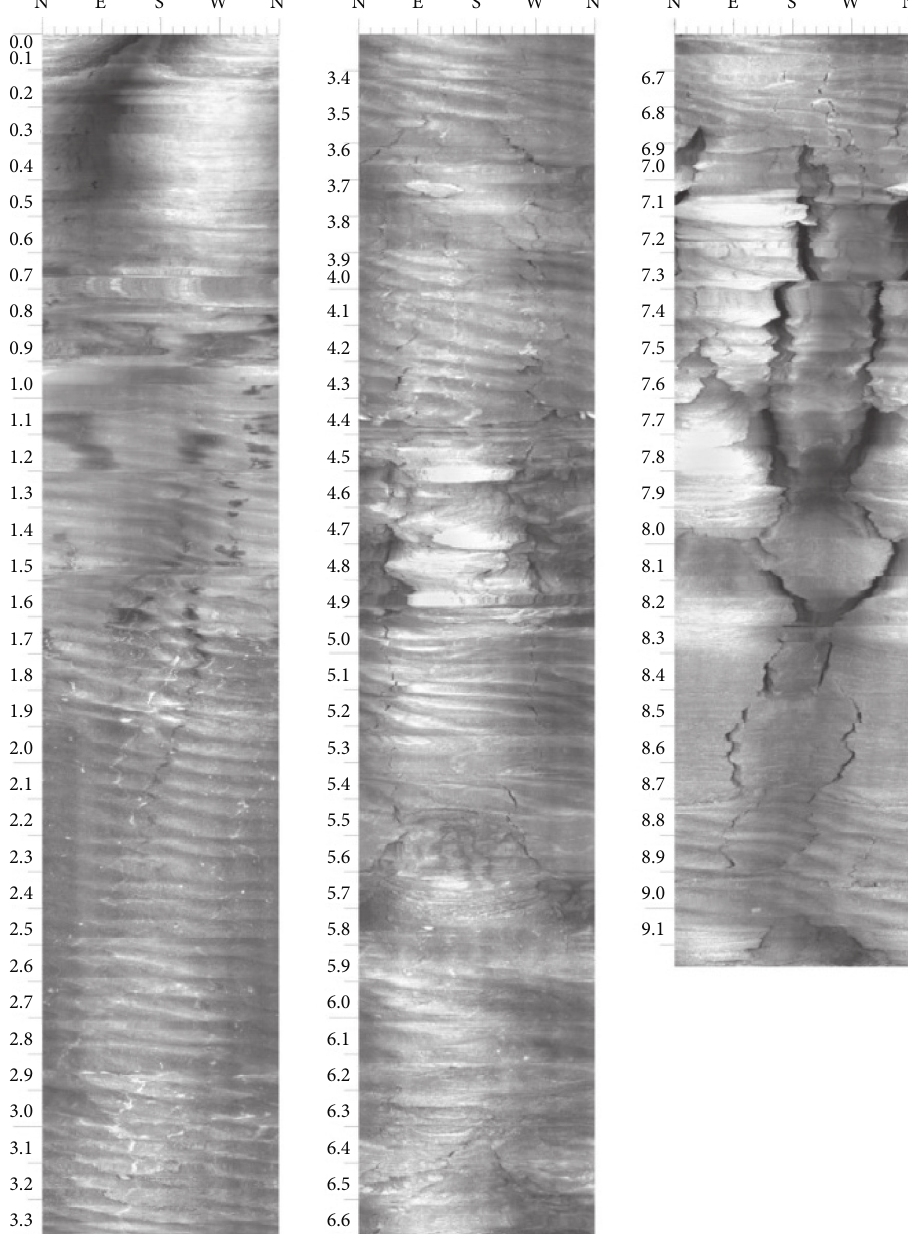
Figure 6: Common presplitting effect in peephole.